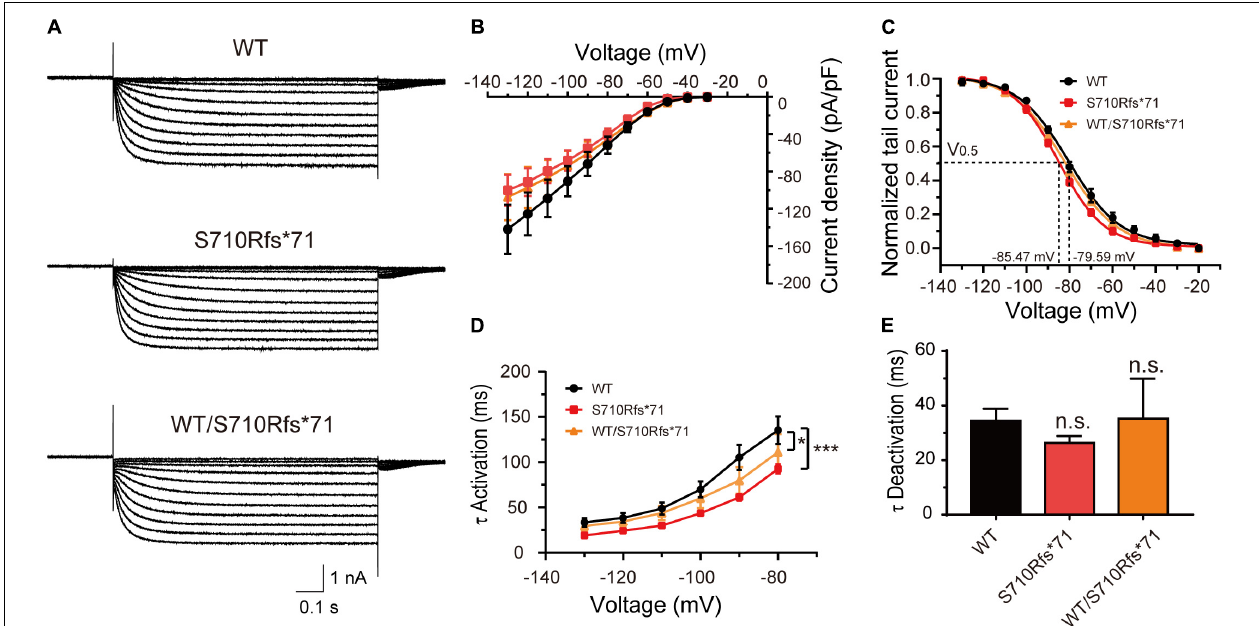
FIGURE 4 | Functional changes of the S710Rfs*71 variant. (A) Representative recordings of currents mediated by HCN1 channels. (B) Plot of mean current densities (pA/pF) of WT, S710Rfs*71, and WT/S710Rf*71 channels (WT: n = 14; S710Rfs*71: n = 20; WT/S710Rfs*71: n = 16). (C) Activation curves obtained by normalizing the tail currents of WT, S710Rfs*71, and WT/S710Rf*71 channels (WT: n = 11; S710Rfs*71: n = 13; WT/S710Rf*71: n = 7). (D) Plot of mean activation time constants obtained for HCN1-WT, S710Rfs*71, and WT/S710Rf*71 channels (WT: n = 16; S710Rfs*71: n = 16; WT/S710Rf*71: n = 6). (E) Bar graph shows mean deactivation time constants obtained for HCN1-WT, S710Rfs*71, and WT/S710Rf*71 channels (WT: n = 12; S710Rfs*71: n = 16; WT/S710Rfs*71: n = 6). All the statistical analyses in this figure were performed by one-way ANOVA and Bonferroni post hoc test. * P < 0.05, *** P <